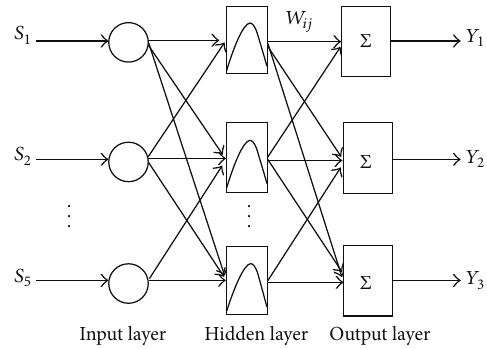
Figure 1: Structure of RBF neural